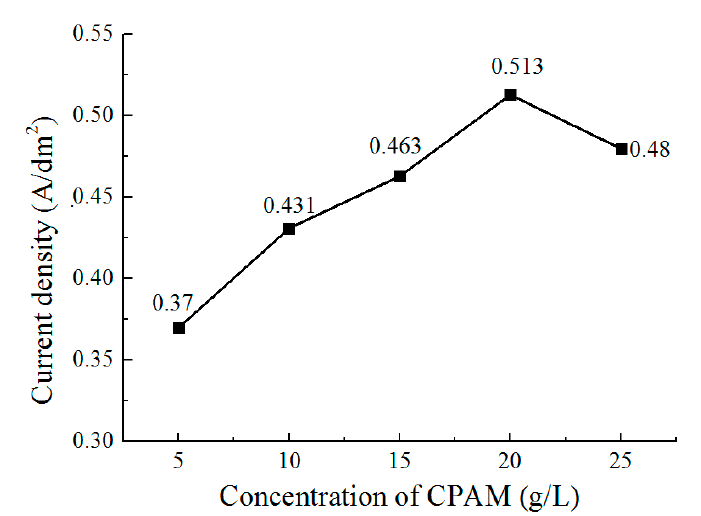
Figure 9. The current density during deposition.